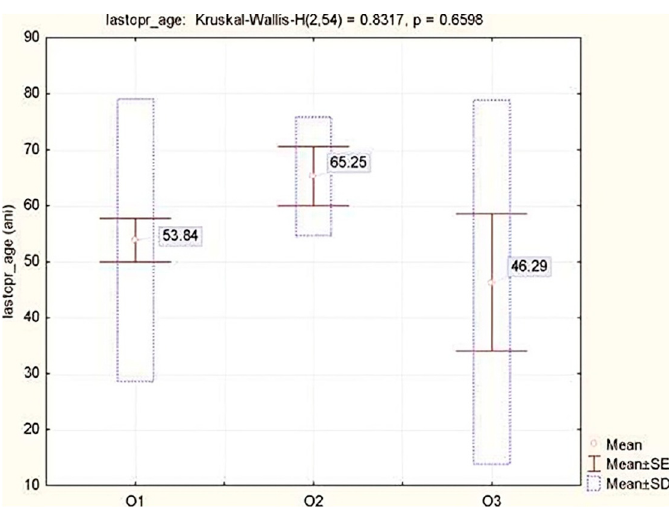
O3. I was sure that resuscitation should not have been initiated.